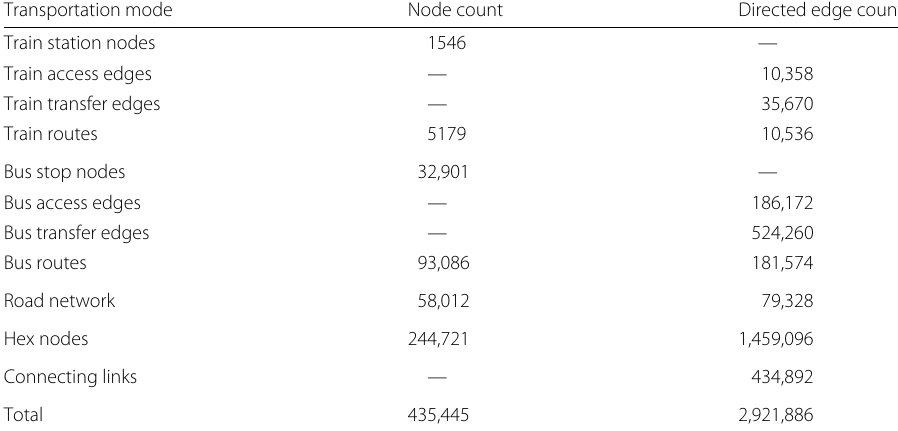
Table 2 Summary of basic network features by transportation